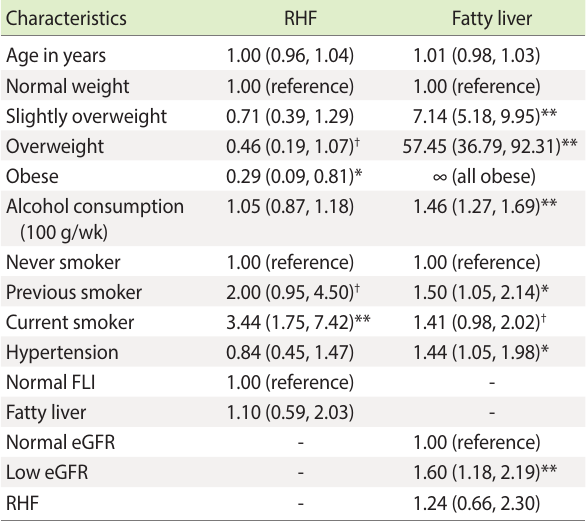
Table 2. RHF and fatty liver with respect to baseline characteristics in the study population